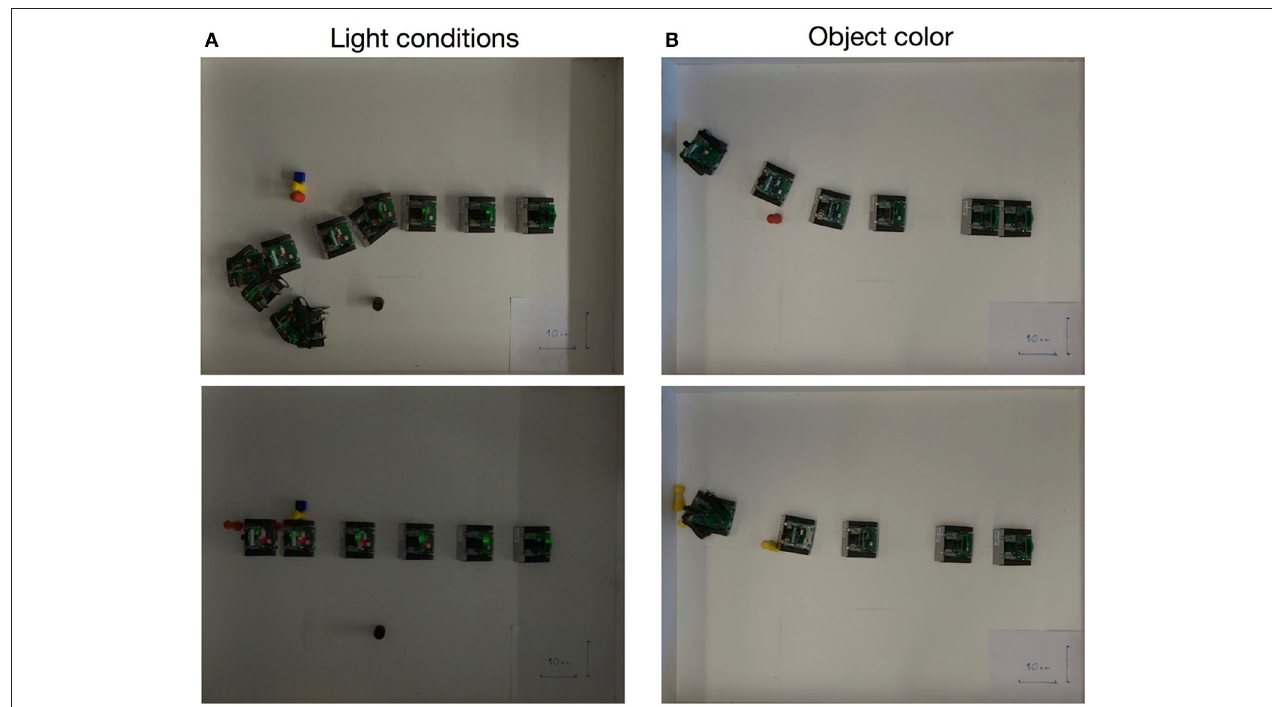
FIGURE 7 | Exemplary experiments showing successful (Top row) and unsuccessful (Bottom row) obstacle avoidance maneuvers in different light conditions (A) and with obstacles of different colors (B) .